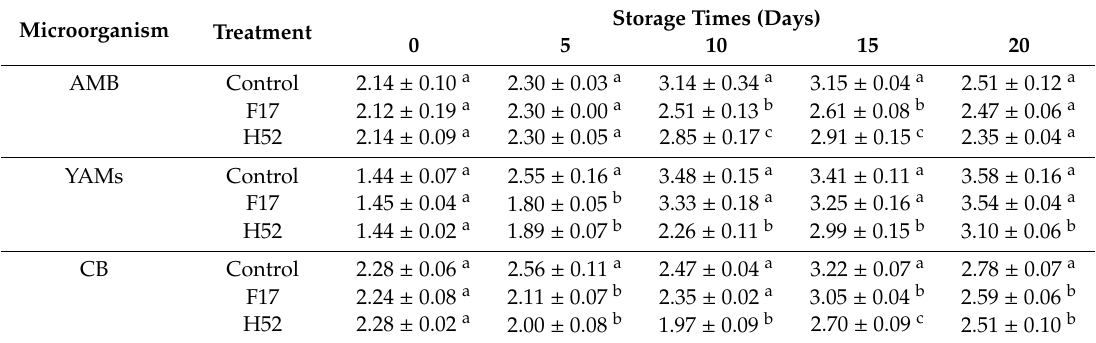
Table 2. Changes in microbial loads (log colony forming units (CFU) / g) of aerobic mesophilic bacteria (AMB), yeast and molds (YAMs), and coliform bacteria (CB) with different bacterial supernatant-treatments on table grapes during storage at 25 °C.